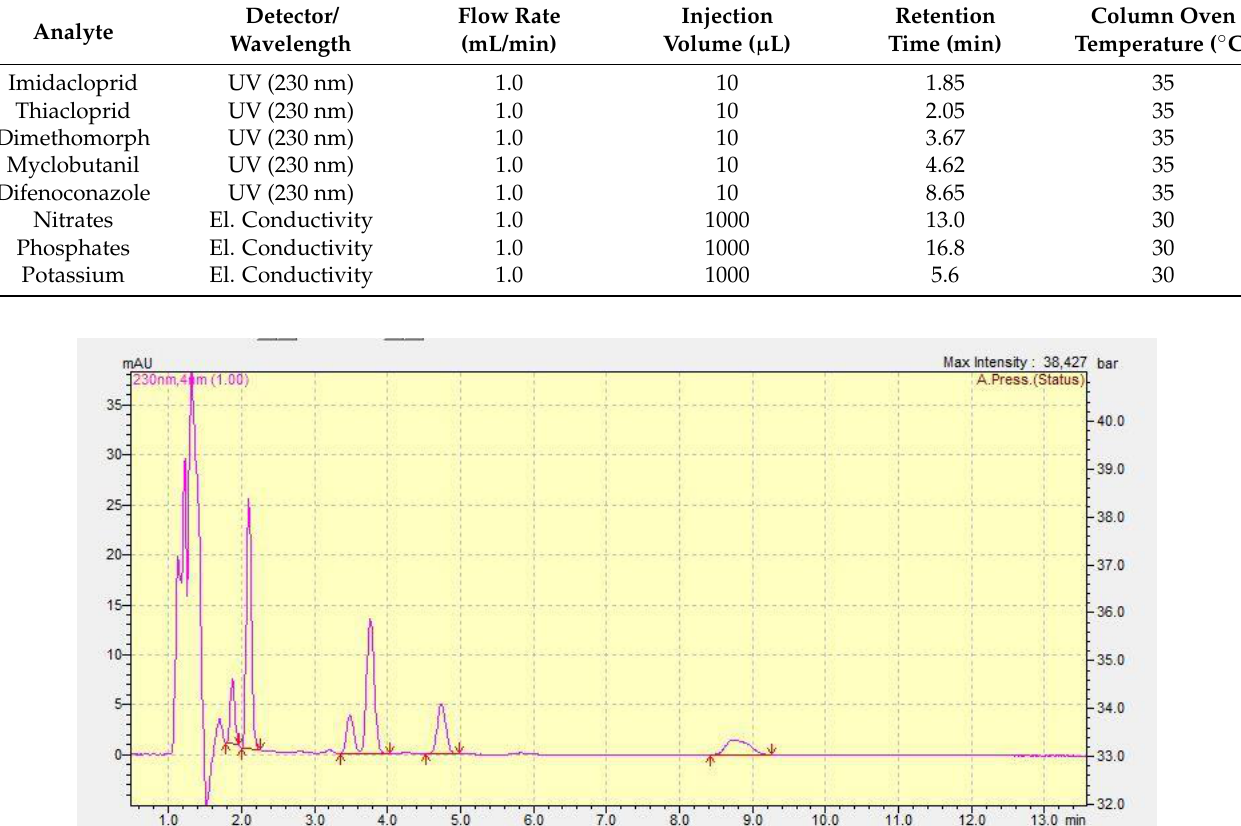
Table 2. Chromatographical parameters.